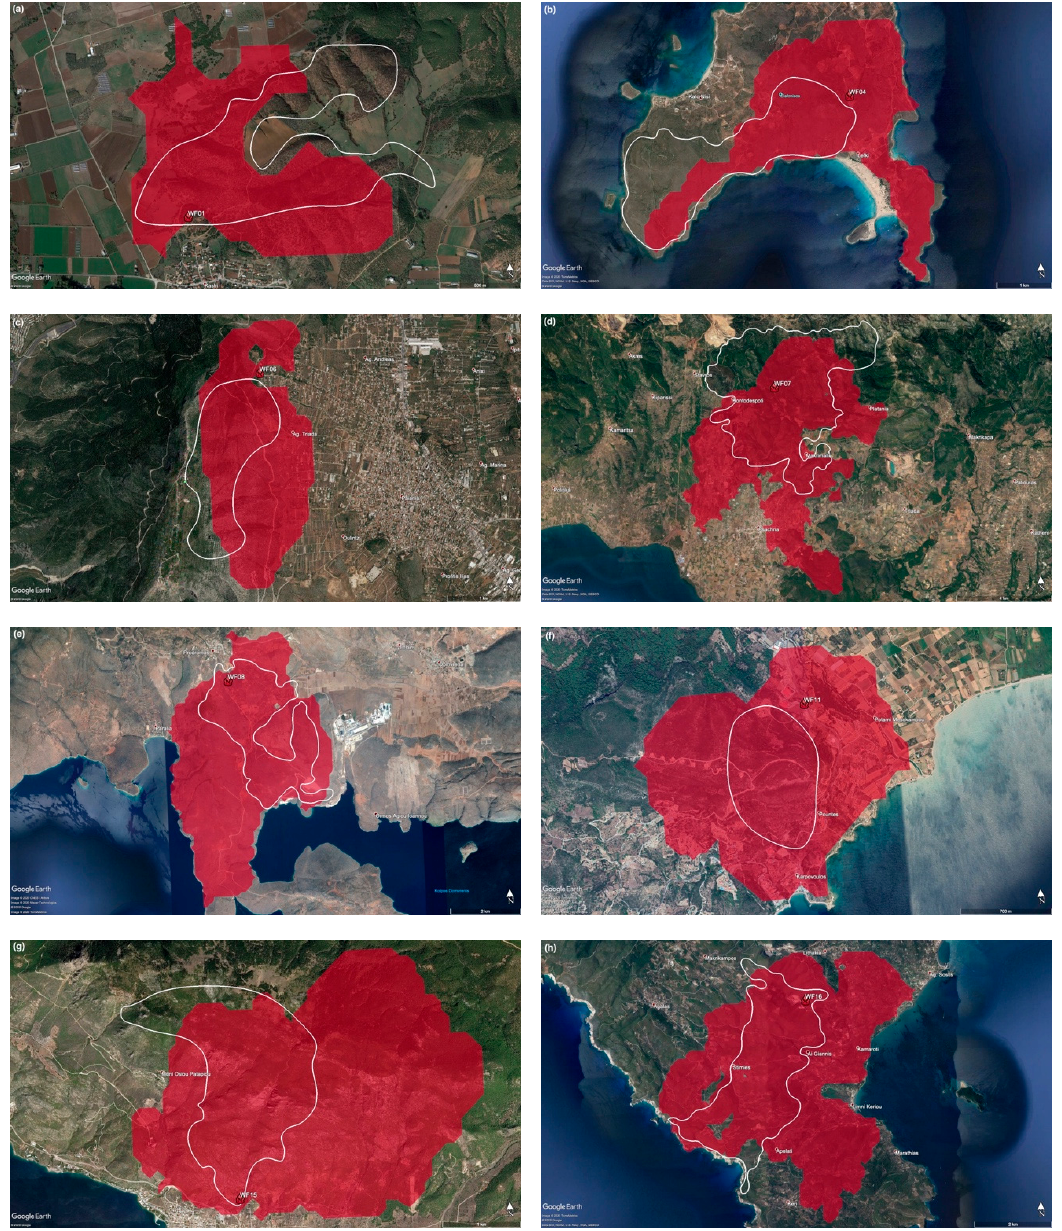
Figure 3. Visual comparison between actual (white contours) and predicted (red shades) wildfire perimeters for the selected events of the 2019 fire season in Greece: ( a ) WF01, ( b ) WF04, ( c ) WF06, ( d ) WF07, ( e ) WF08, ( f ) WF11, ( g ) WF15, and ( h ) WF16.